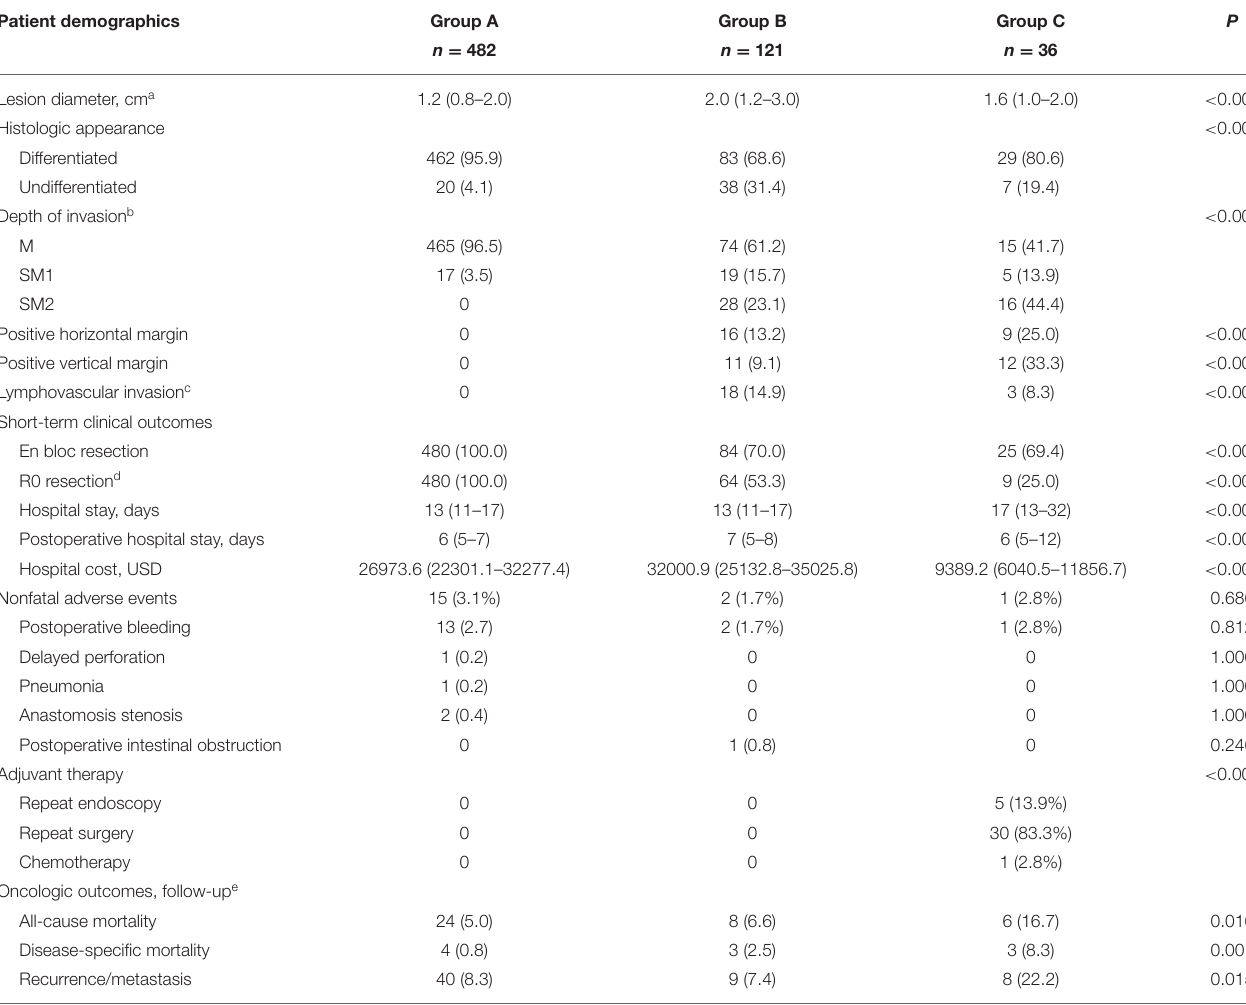
TABLE 2 | Pathological result and outcomes of endoscopic submucosal dissection for the 639 elderly patients with gastric